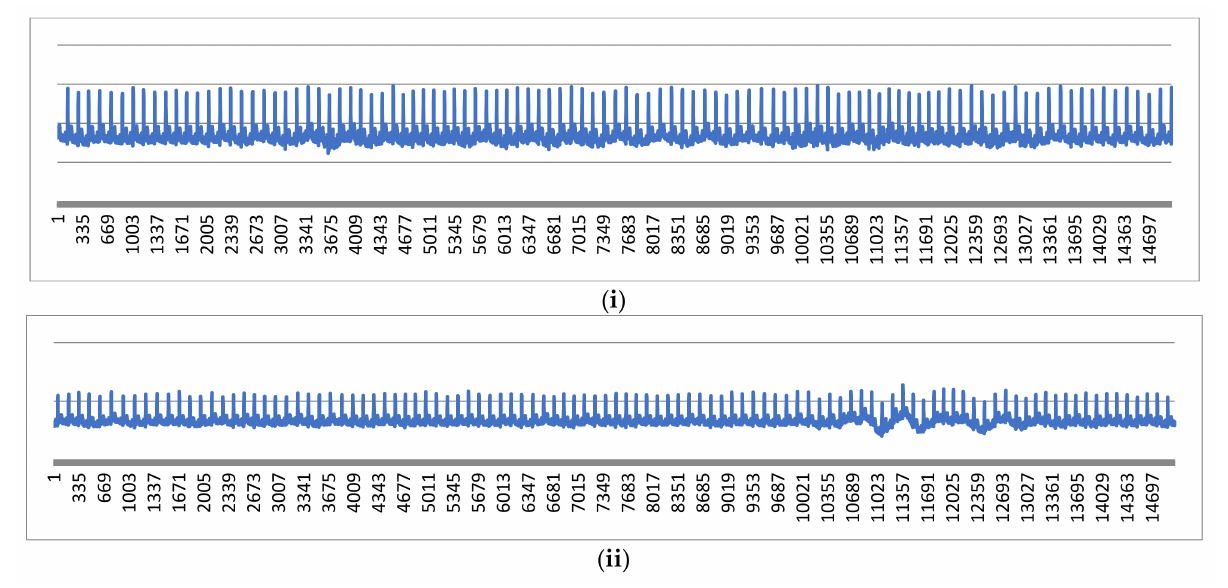
Figure 7. First 15,000 samples from ( i ) signal 1 and ( ii ) signal 2.